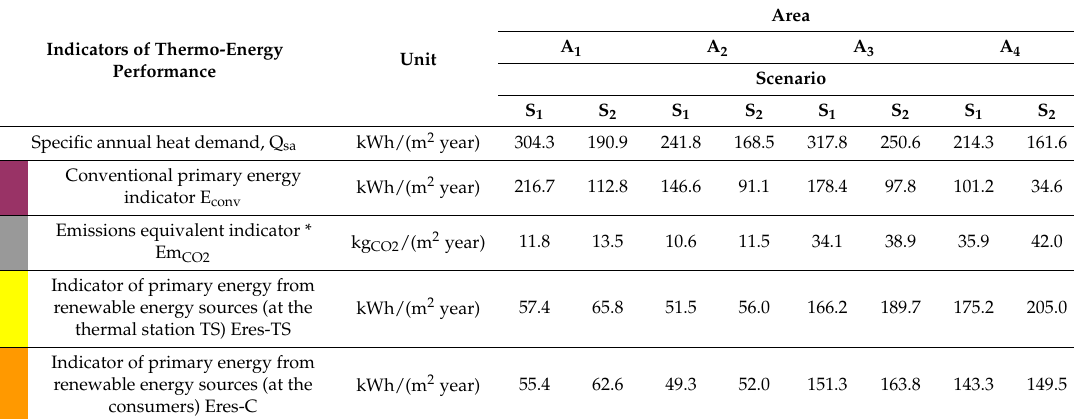
* natural gases as a reference. The background colours correspond to the graphic representations in Figure 9. Eres-TS and Eres-C (kWh/m 2 year) are indicators of primary energy from renewable